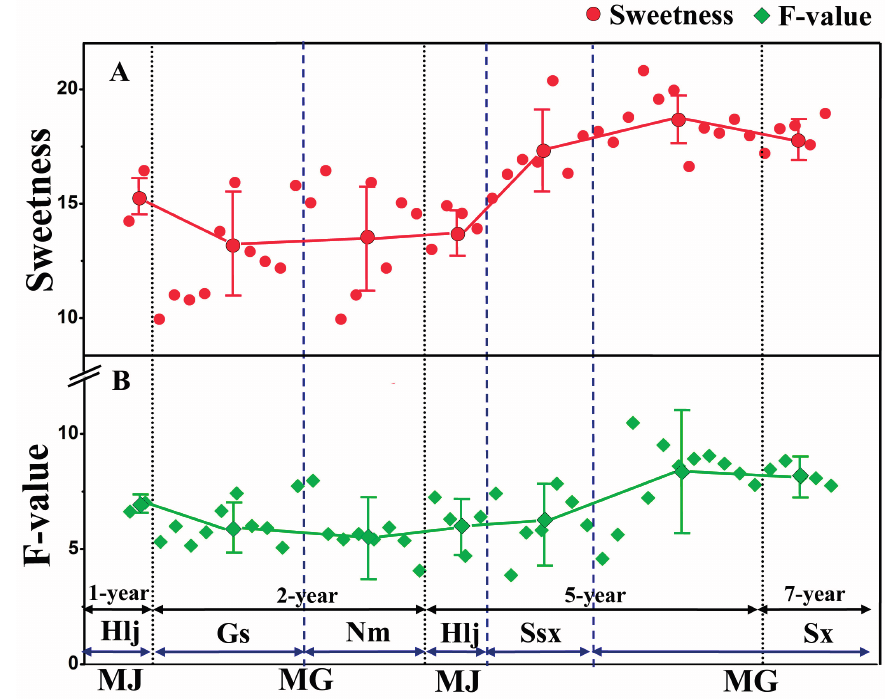
Figure 4. Scatter plots of sweetness ( A ) and F-value ( B ) of comprehensive evaluation of RA. Scatter plot showing the averages and degrees of dispersion of sweetness and comprehensive evaluation of RA; Sweetness indicates relative sweetness of RA with the sweetness of 10% sucrose solution considered to be 1.0; F value indicates the quality of RA with higher F value corresponding to higher integrated quality of RA; MG ( A. membranaceus var. Mongholicus (Bge.)) and MJ ( A. membranaceus (Fisch.) Bge.) represent the two species of RA; FA (fast-growing RA (1–2 years samples)) and PA (perennial RA (5–7 years samples)) represent the two different growth years of RA; Sx (Shanxi province), Ssx (Shaanxi province), Gs (Gansu province), Nm (Inner Mongolia), and Hlj (Heilongjiang province) represent the five regions of